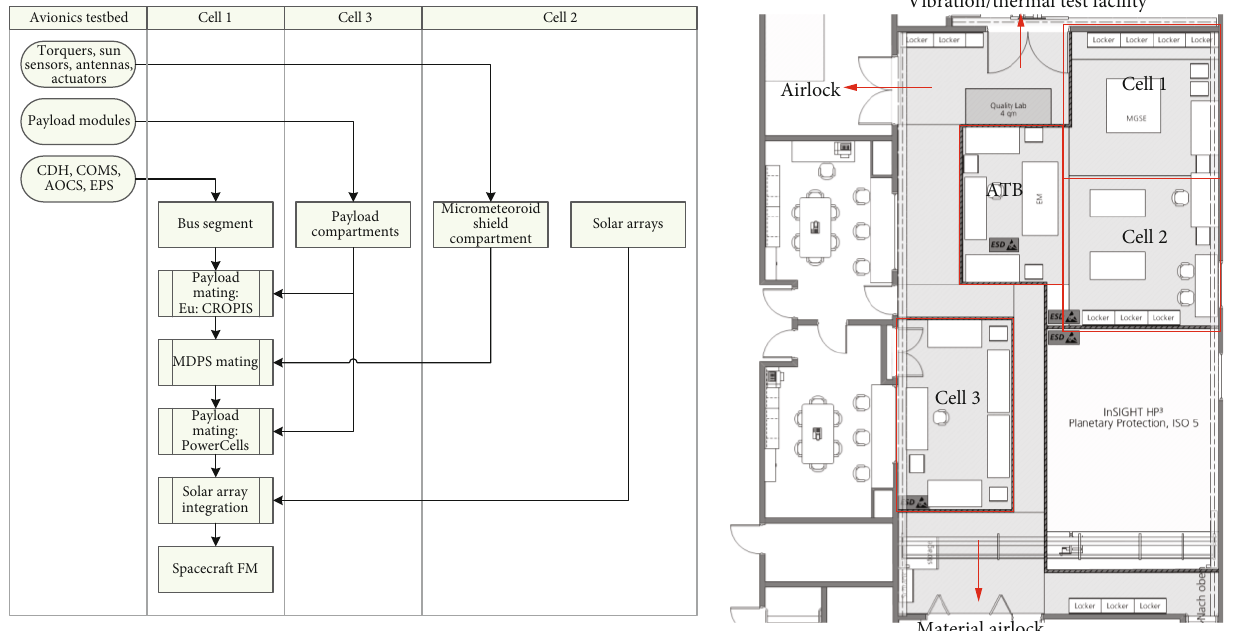
Figure 9: Cellular production approach as implemented in the integration cleanroom facility (90 m 2 in total).